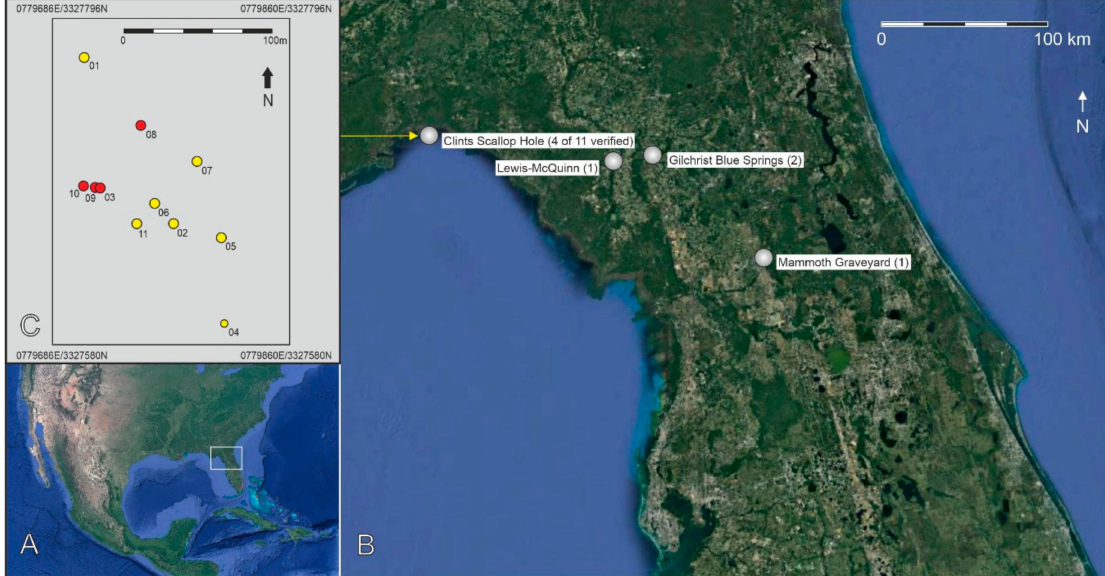
Figure 11. The sites in Florida, USA detected or tested by Smith and Joy. ( A ): overview. ( B ): Positions of the 15 sites ( C ): Detailed positions of the detected anomalies (yellow) and verified sites (red) at Clints Scallop Hole. Zone 17R UTM coordinates. Graphics: